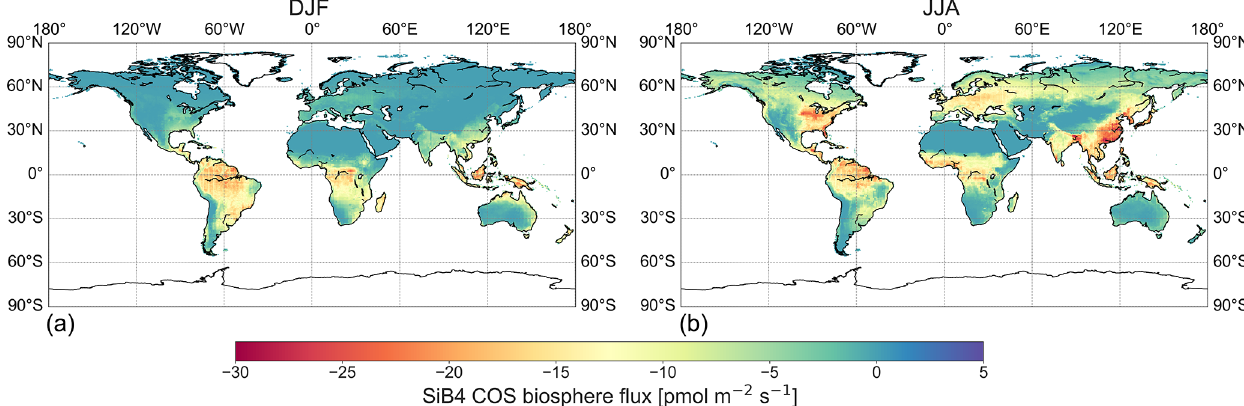
Figure 5. Global distribution of the COS biosphere flux in DJF (a) and JJA (b) as simulated by SiB4_var_Ogee over the years 2000–2020. Negative values indicate uptake of COS by the biosphere, while positive values indicate COS emissions.